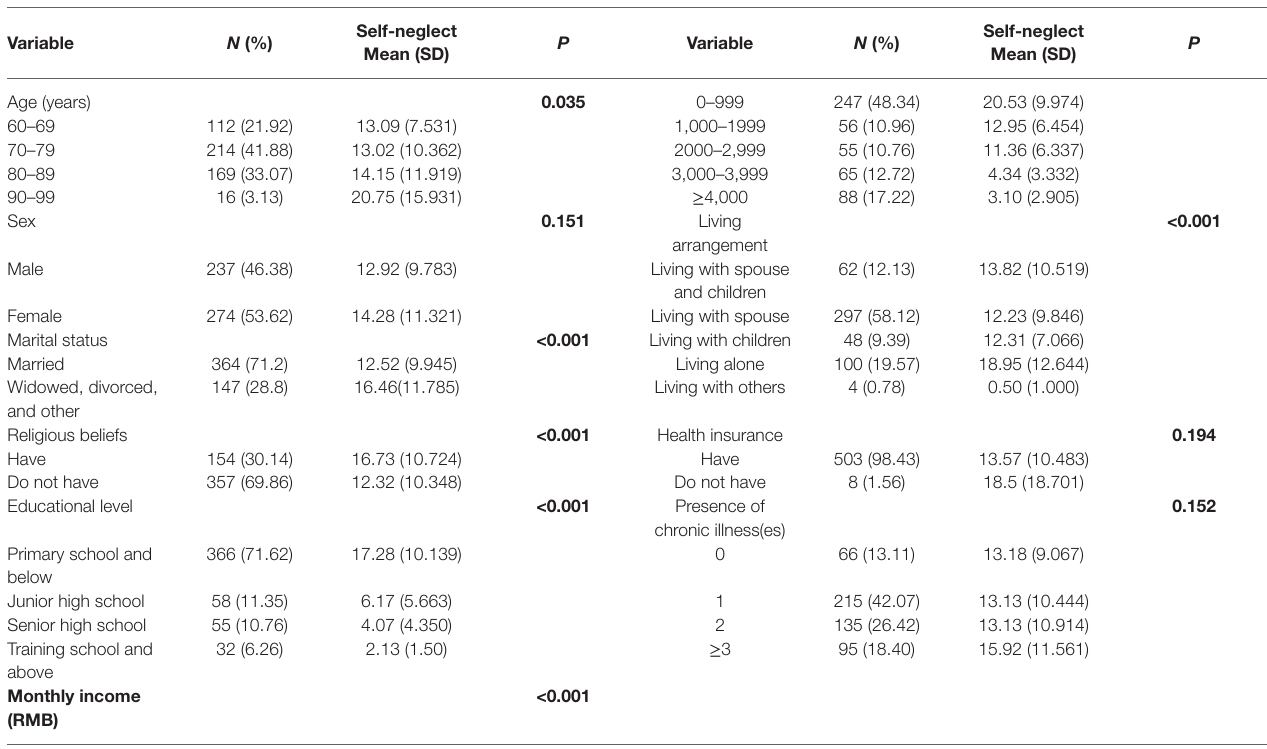
TABLE 1 | Sociodemographic characteristics of the participants ( N =